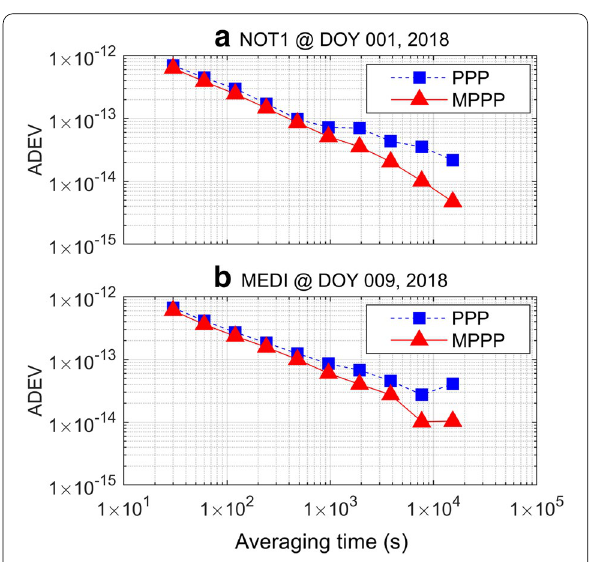
Fig. 8 Comparison of Allan deviation of the receiver clock error between the original PPP (blue lines) and modified PPP (red lines) at station NOT1 on day 001 in 2018 and MEDI on day 009 in